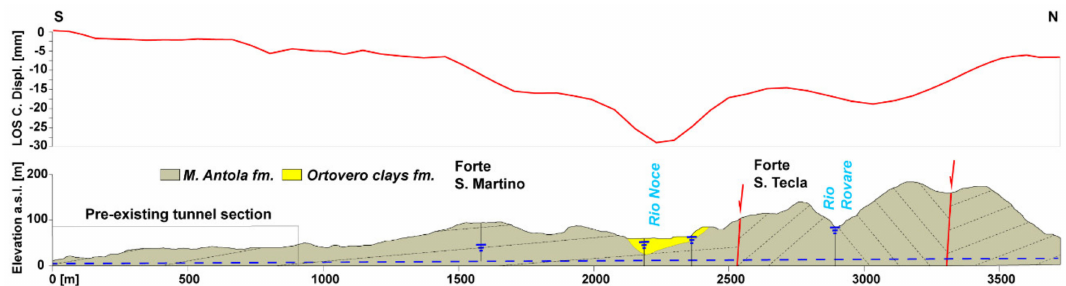
Figure 7. Geological section along the Fereggiano overflow tunnel (drawn as a blue dotted line). The red line represents the longitudinal profile along the tunnel axis of the LOS cumulative displacement (ascending orbit). The water table level (blue triangle) and the location of boreholes (black vertical line) are also show. Elevation exaggeration: